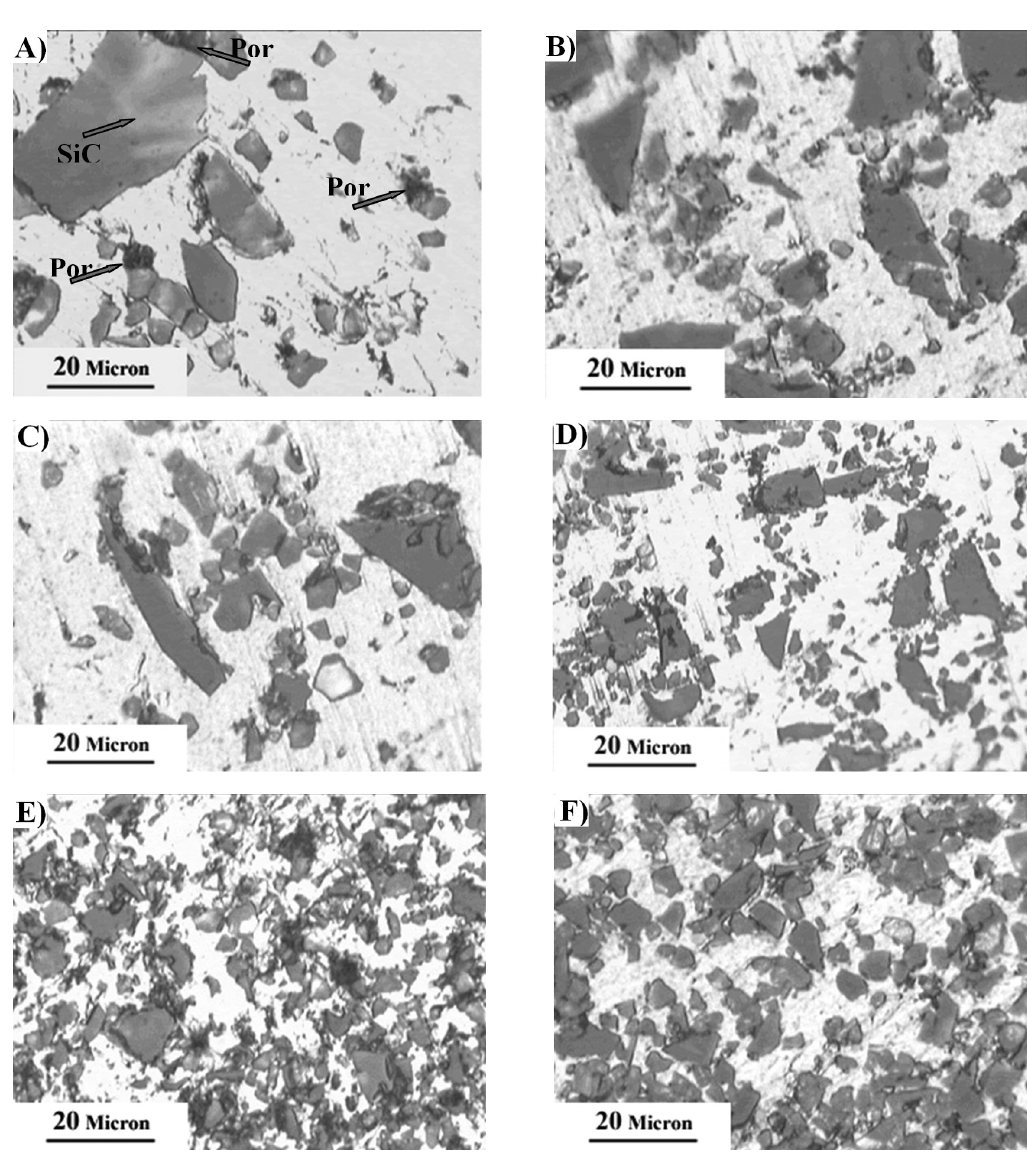
Figure 3. Optical microscopy images of Al-SiC composites; A) 10%SiC mesh 400, P.M., B) 10%SiC mesh 400, EX., C) 10%SiC mesh 400, H.P., D) 10%SiC mesh 1000, EX., E) 15%SiC mesh 1000, EX., and F) 20%SiC mesh 1000, H.P.